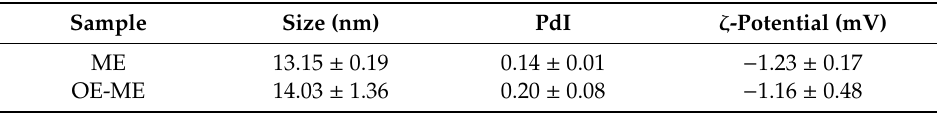
Table3. PhysicalcharacterizationofMEandoliveextract-ME.Resultsareexpressedasmeans ± standard deviation of at least three